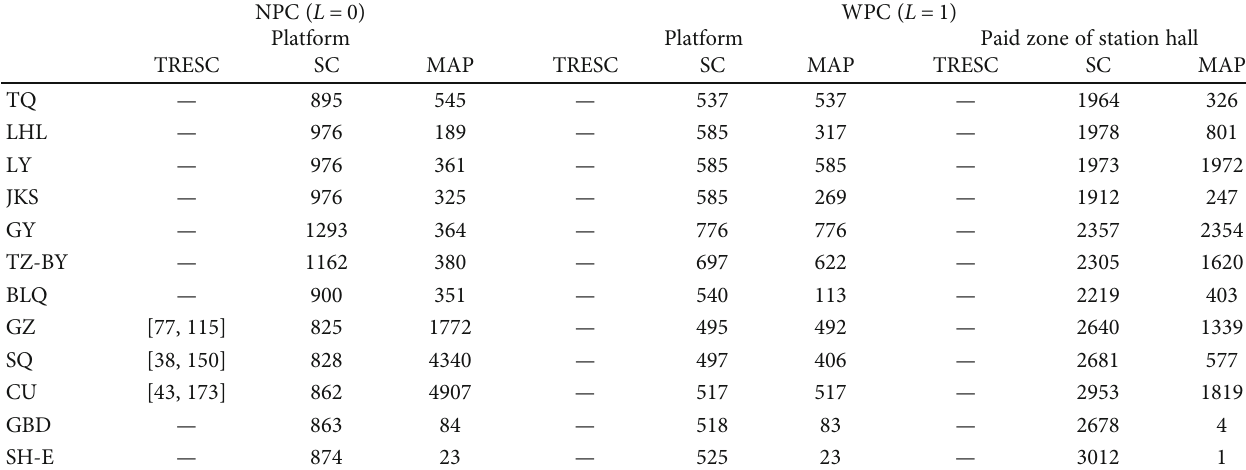
Table 5: The time range for exceeding the safe capacity in each key area of all stations ( L = 1 ).